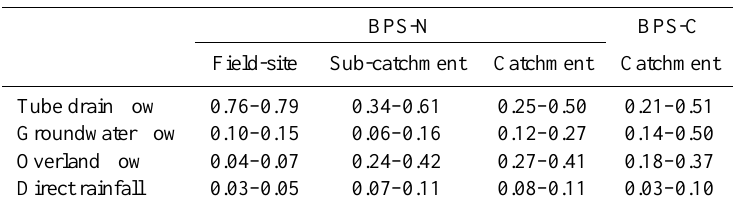
u ET does not affect the model